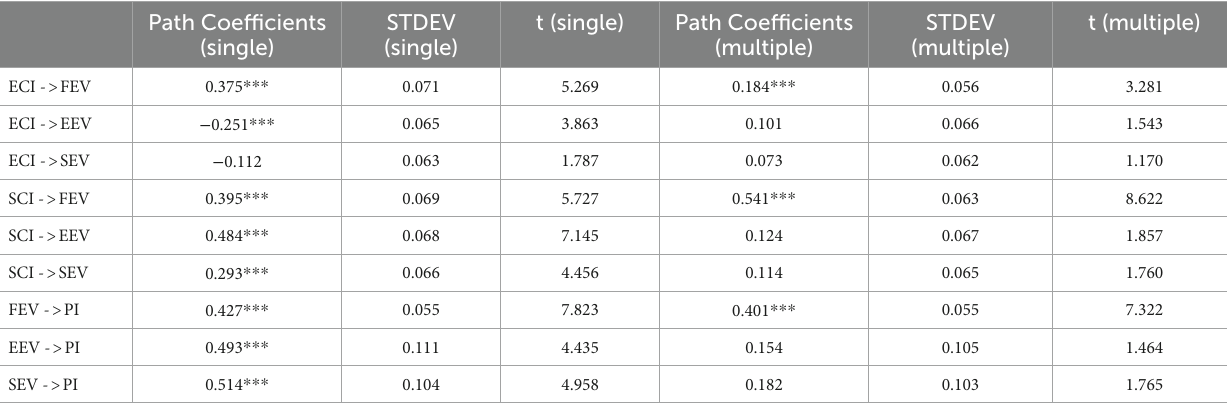
TABLE 7 Impact of environmental and interpersonal interactions on purchase intention of EVs under different business